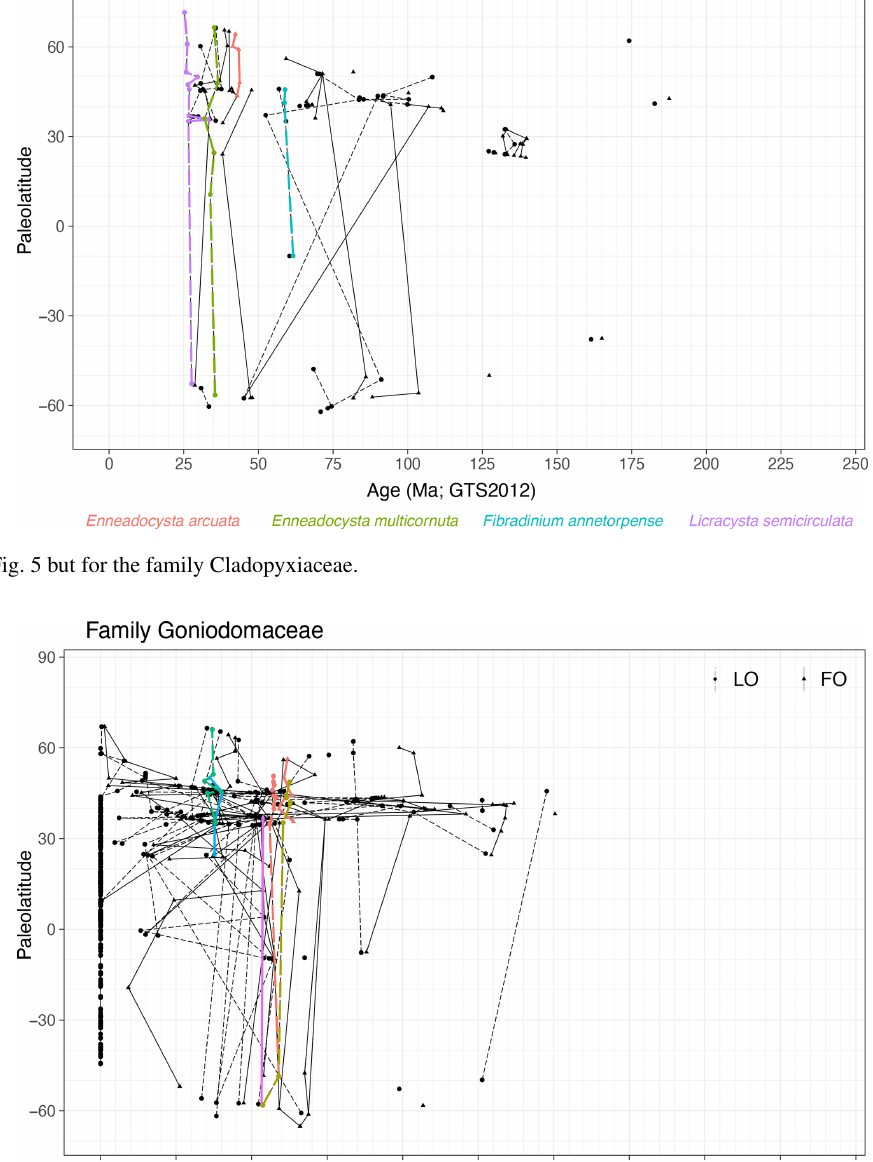
ranges. The subfamily has many entries in the Paleogene, but many of these events are not synchronous